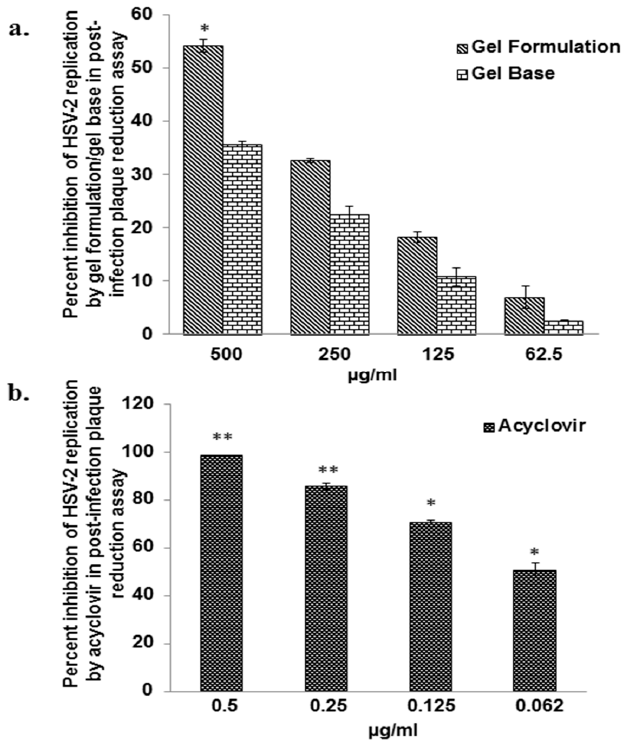
Figure 4. Effect of the gel formulation on HSV-2 replication in Vero cells and its spreading. Monolayer of Vero cells in 24-well culture plate was infected with HSV-2 (100 PFU/well) followed by 1% low melting point agarose overlay medium containing varying concentration of the gel formulation and acyclovir as described in Materials and Methods section. ( Panel a ) represents the efficacy of the gel formulation as well as gel base at different concentrations to inhibit formation of plaques by HSV-2. ( Panel b ) represents the efficacy of acyclovir to inhibit HSV-2 replication. The Y-axis represents percent inhibition in the number of plaques with respect to the untreated virus control group and X-axis the concentration of the gel formulation/gel base/acyclovir. Each bar in ( Panels a and b ) represent mean ± SEM of the three independent experiments performed in duplicate. * p ≤ 0.05, ** p ≤ 0.005, respectively, between treated and untreated control at tested concentration of the acyclovir/gel formulation.